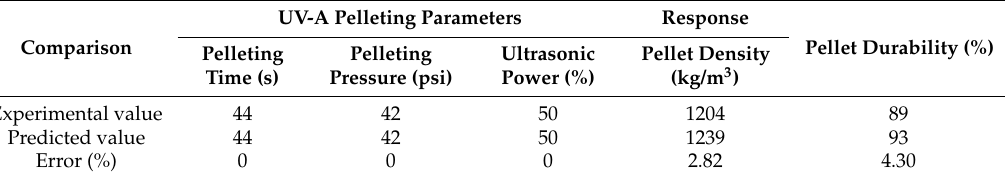
Table 8. The results of the confirmation